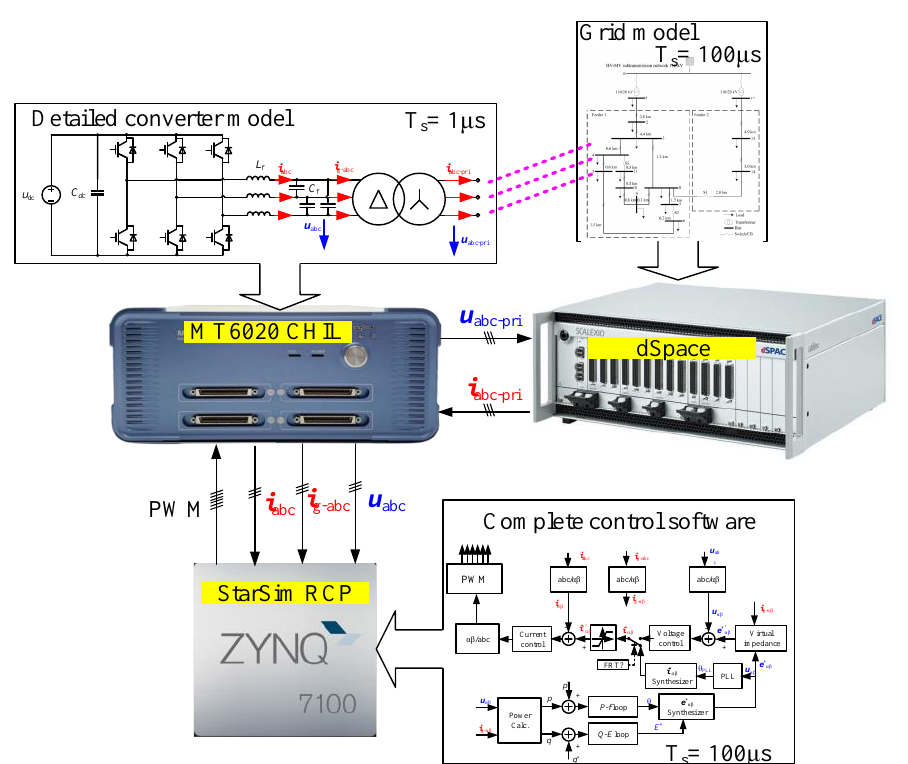
Figure 16. Topology of the joint controller hardware-in-the-loop system.